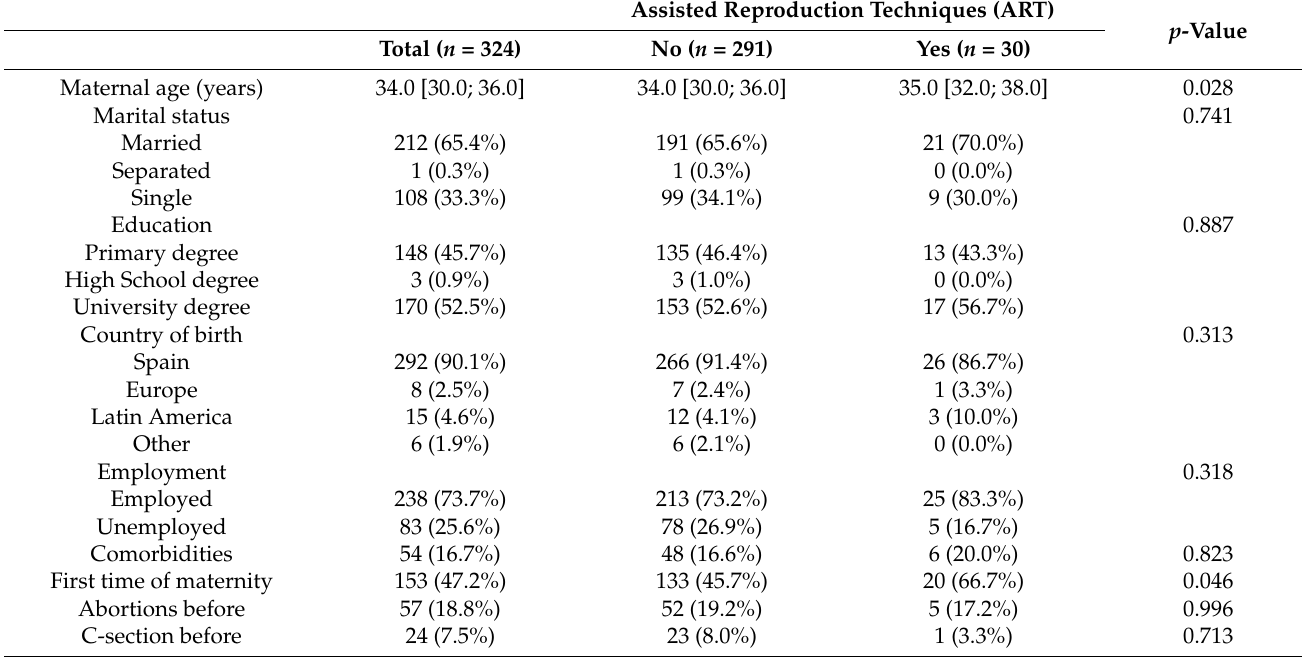
Table 1. Sociodemographic characteristics compared to assisted reproduction